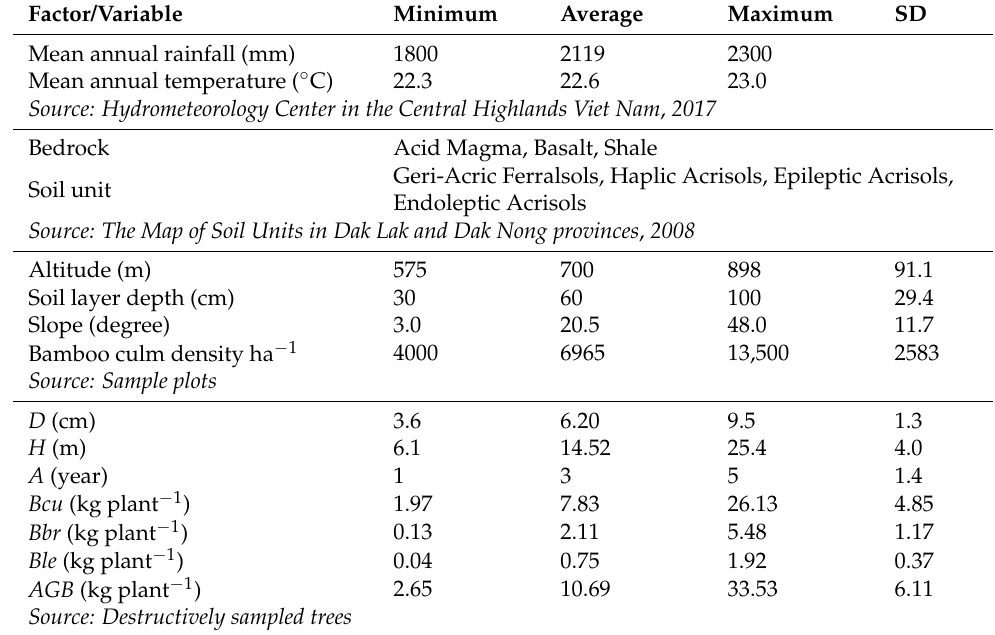
Figure 1. Map of natural bamboo distribution and location of sample plots in the Central Highlands of Viet Nam. Table 1. Summary of selected variables at the sample plot locations and summary statistics for variables of destructively sampled bamboo